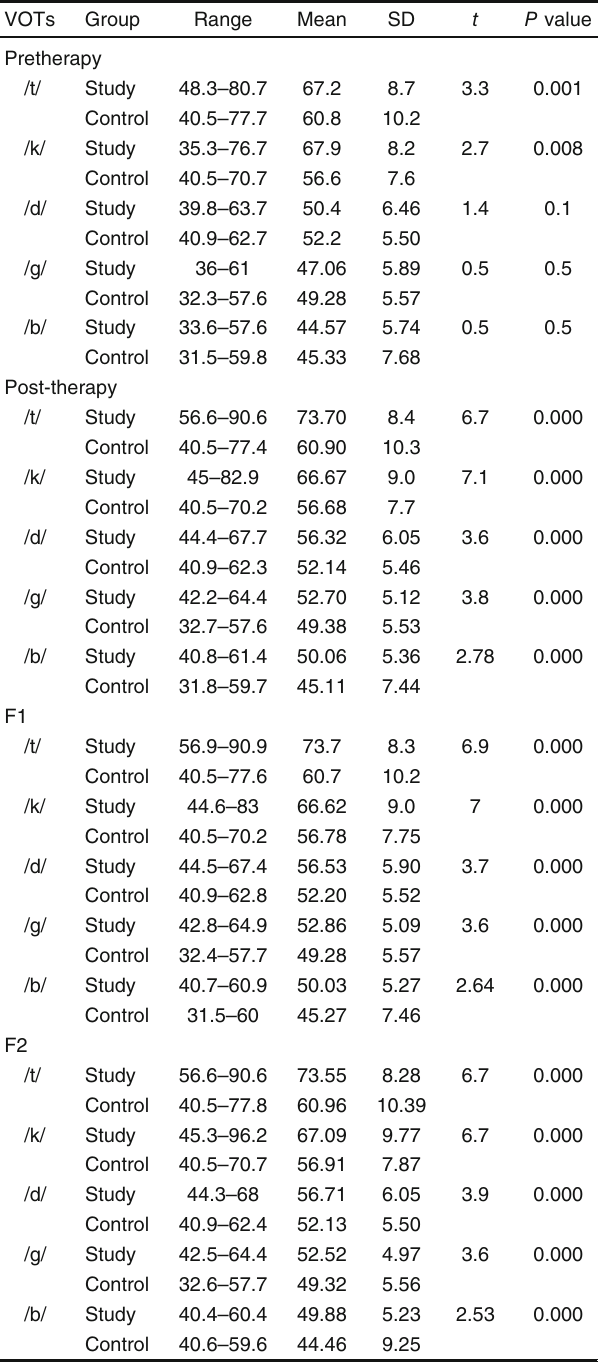
Table 7 Comparison between the study group and the control group as regards voice onset time